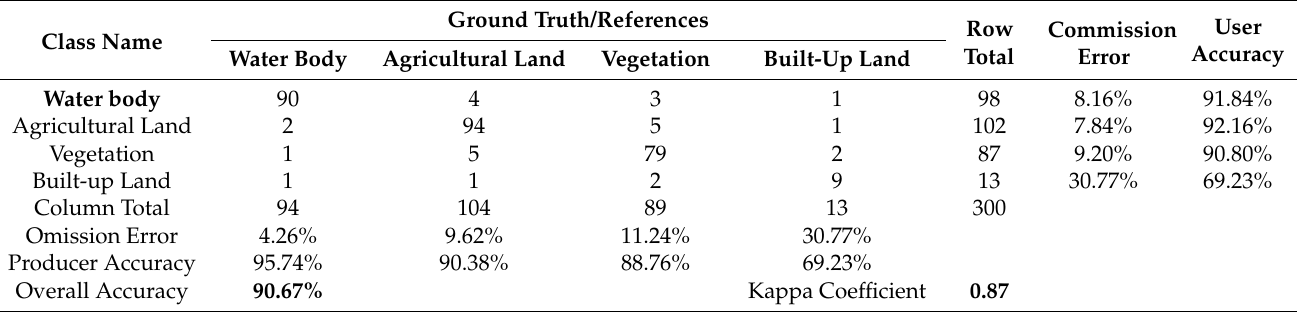
Figure 6. Water body change analysis of different study time. Table 6. Accuracy assessment and kappa coefficient in the year of